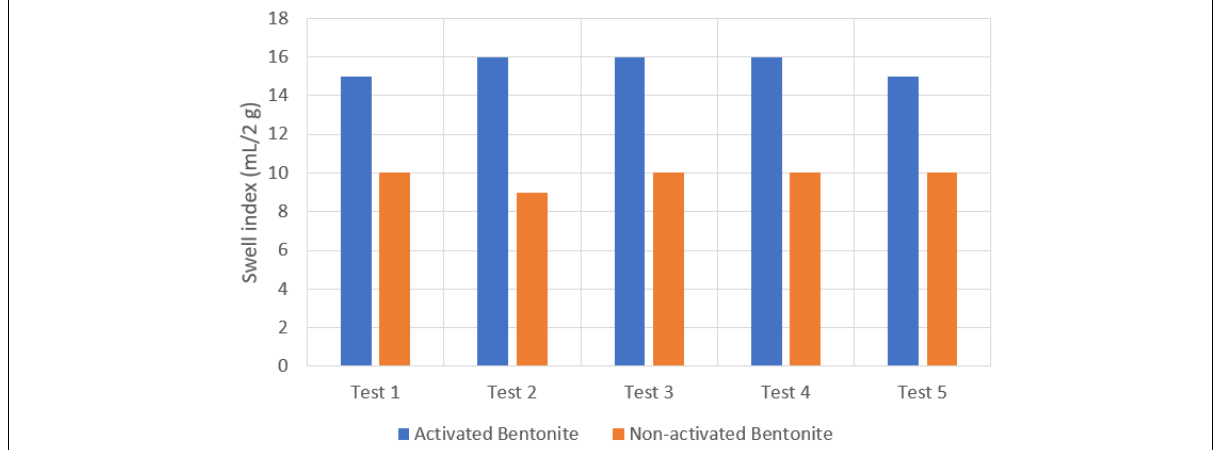
Figure 4: Swell index of activated bentonite and non-activated